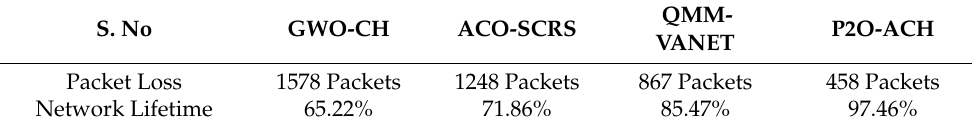
Figure 5. Network Lifetime Calculation. Table 6. Performance Values of Packet Loss and Lifetime Calculation of the Network.